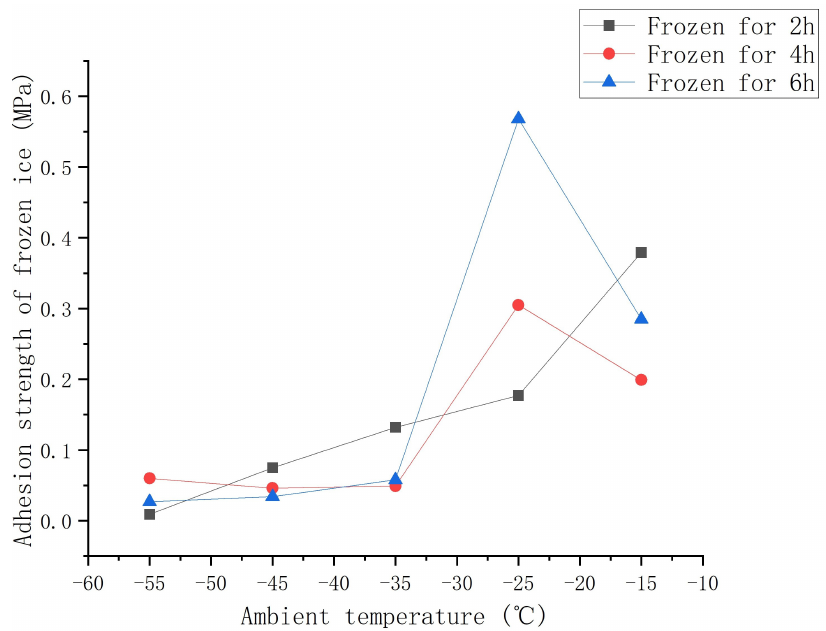
Figure 5. Adhesion strength of frozen ice on the aluminum alloy surface.